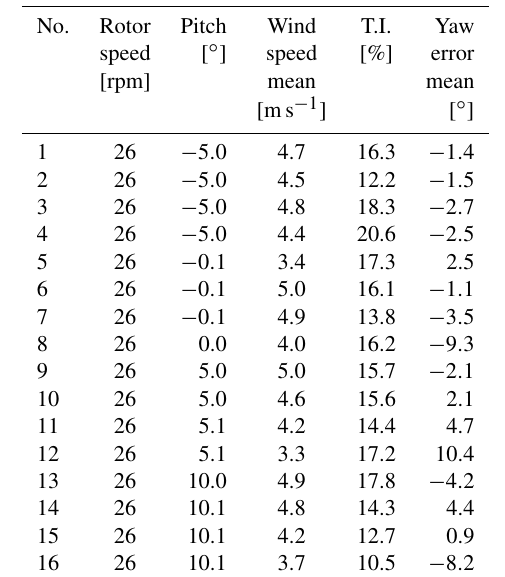
Table 2. Parameters of all measured cases.